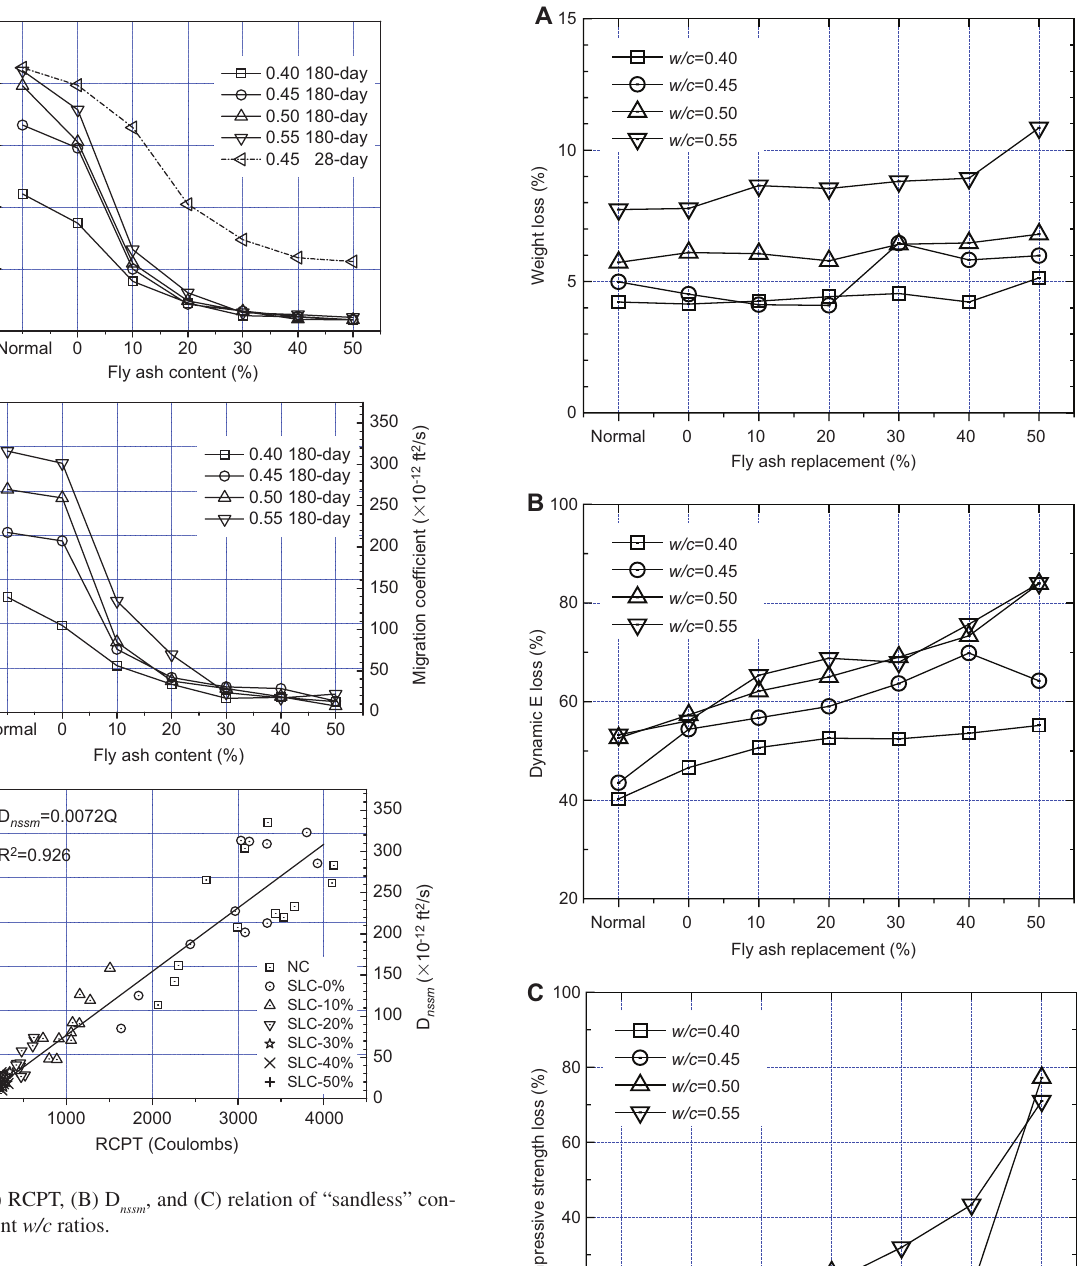
, and (C) relation of “ sandless ” con- nssm